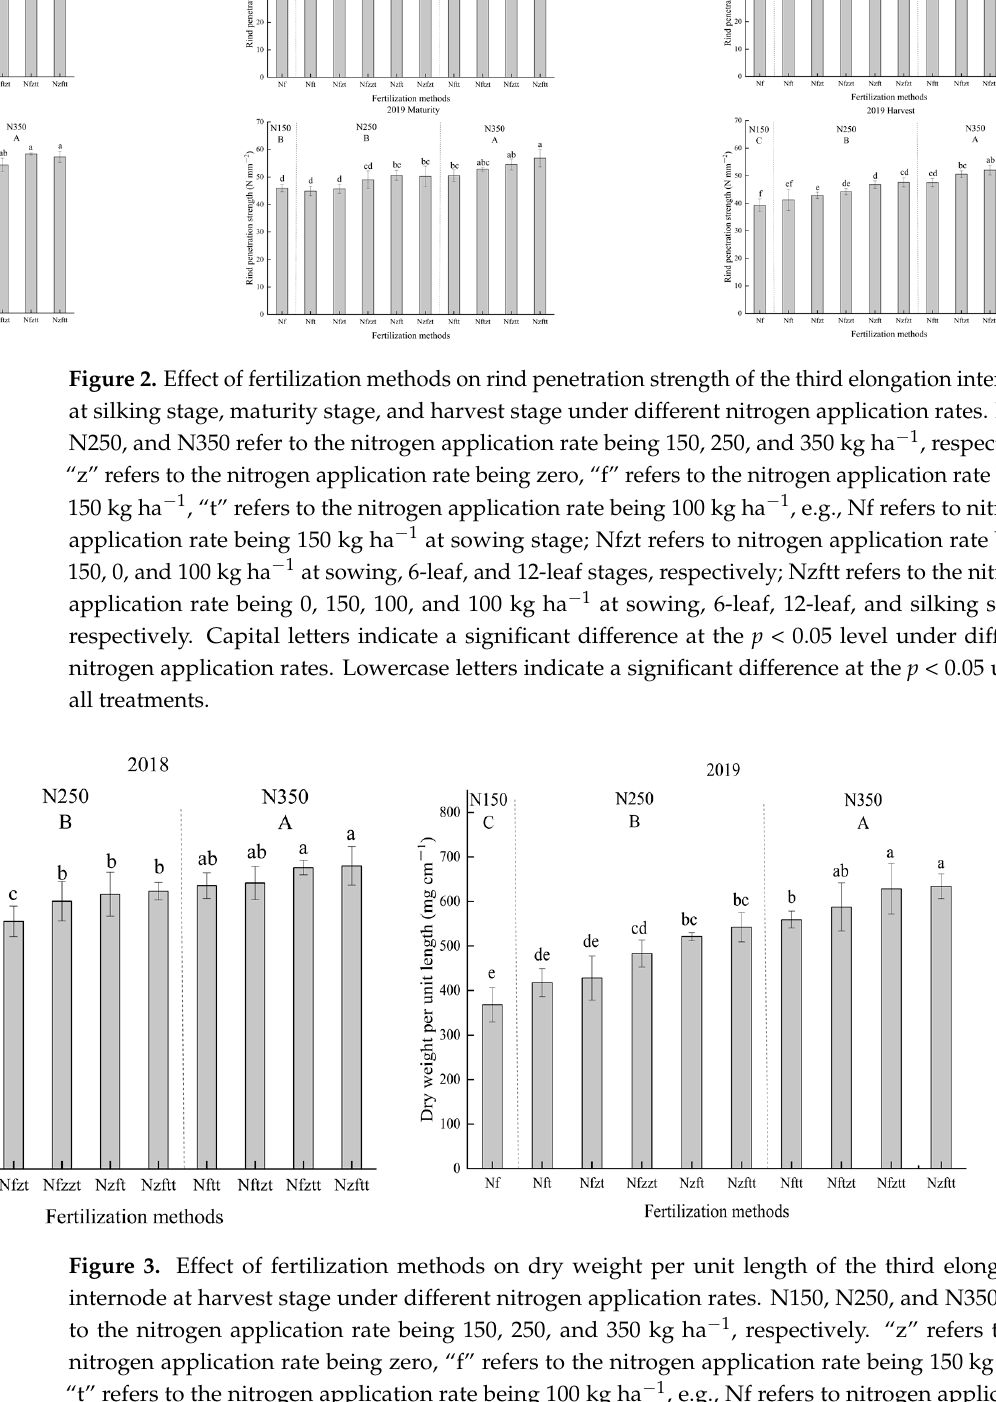
Figure 3. Effect of fertilization methods on dry weight per unit length of the third elongation internode at harvest stage under different nitrogen application rates. N150, N250, and N350 refer to the nitrogen application rate being 150, 250, and 350 kg ha − 1 , respectively. “z” refers to the nitrogen application rate being zero, “f” refers to the nitrogen application rate being 150 kg ha − 1 , “t” refers to the nitrogen application rate being 100 kg ha − 1 , e.g., Nf refers to nitrogen application rate being 150 kg ha − 1 at sowing stage; Nfzt refers to nitrogen application rate being 150, 0, and 100 kg ha − 1 at sowing, 6-leaf, and 12-leaf stages, respectively; Nzftt refers to the nitrogen application rate being 0, 150, 100, and 100 kg ha − 1 at sowing, 6-leaf, 12-leaf, and silking stages, respectively. Capital letters indicate a significant difference at the p < 0.05 level under different nitrogen application rates. Lowercase letters indicate a significant difference at the p < 0.05 under all